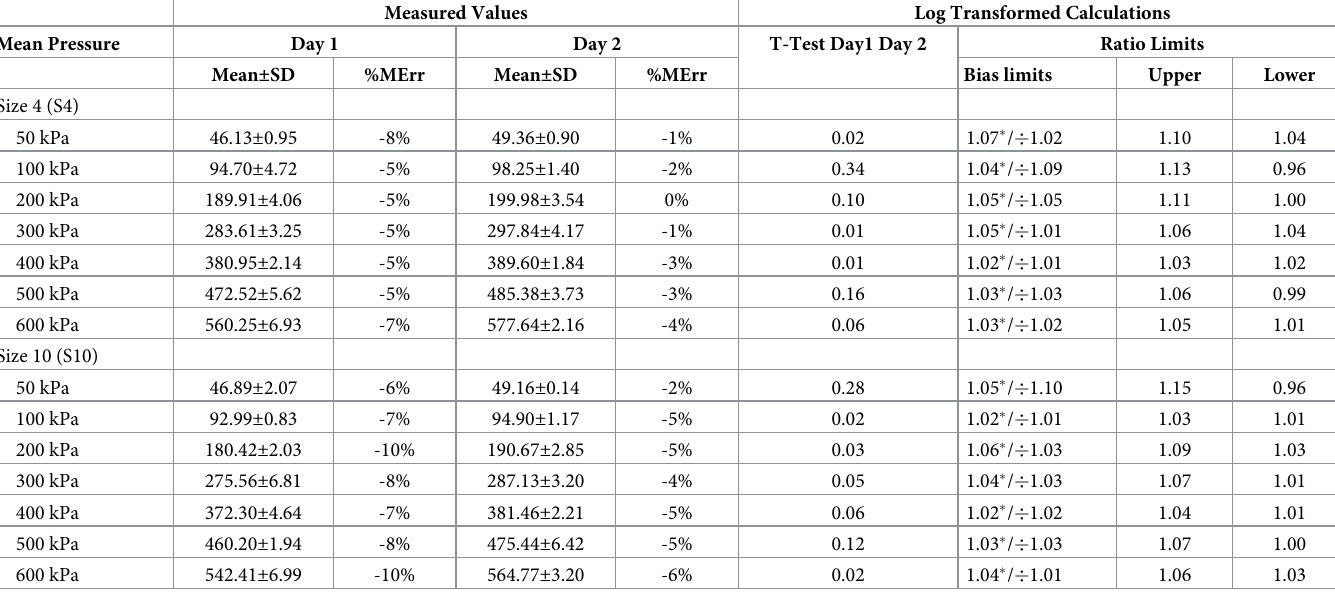
Table 2. Average mean pressure at each target pressure at 2 seconds for Day 1 and Day 2, the differences, and the “ratio limits of agreement” alongside the t-test between the measures of day 1 and 2. Measured Values Log Transformed